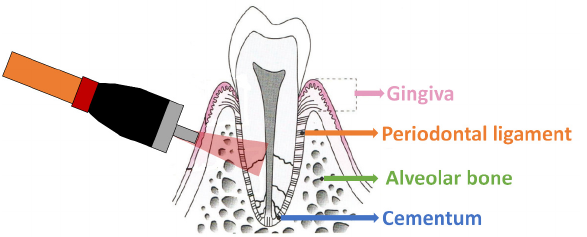
periodontal tissues. Adapted from Cope